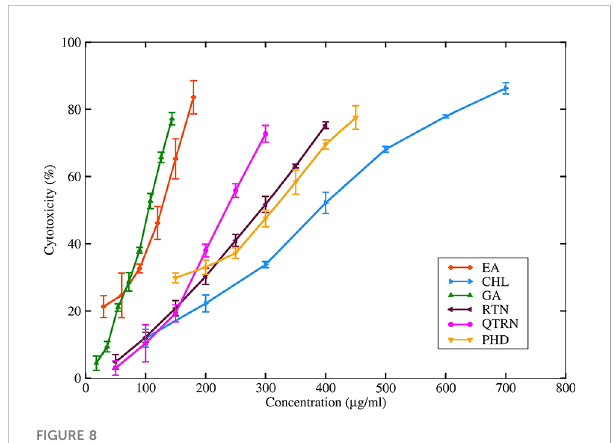
FIGURE 8 IC 50 of six herbal compounds determined by MTT assay on CHO cell